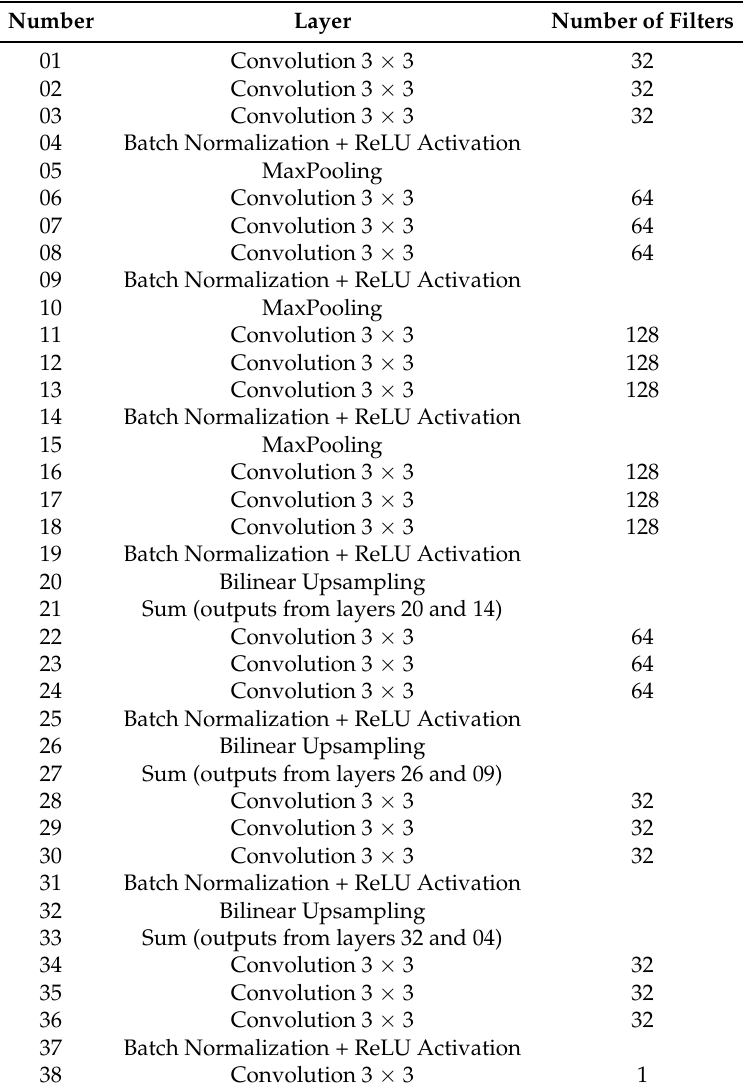
Table 1. Network architecture